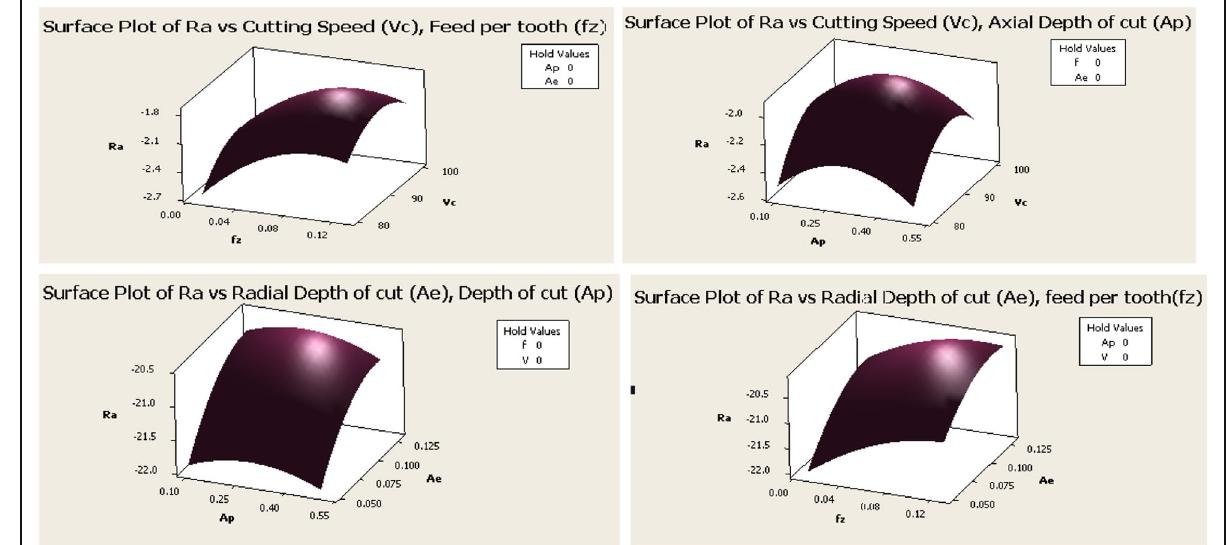
Fig. 8 3D surface interaction effect of the input